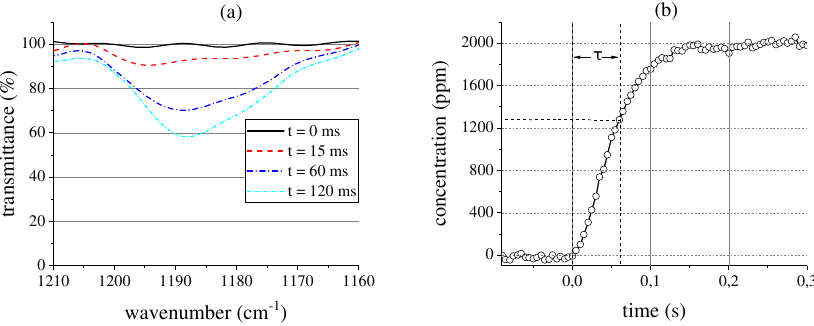
Figure 8. ( a ) Decreasing transmittance around 1189 cm − 1 for selected times when filling the single pass cell with a 2000 ppm R134a probe at a volume flow rate of 1 L min − 1 ; ( b ) Corresponding gas concentration increase in the cell measured at 200 Hz.